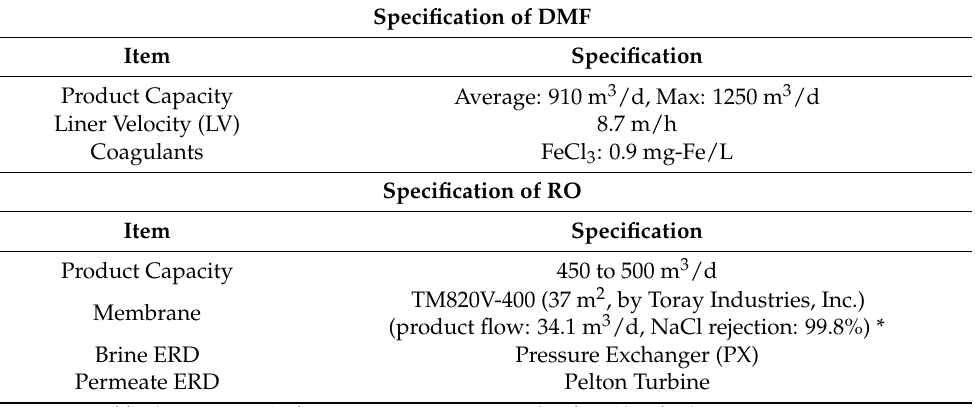
Table 1. Technical specification of pilot plant.